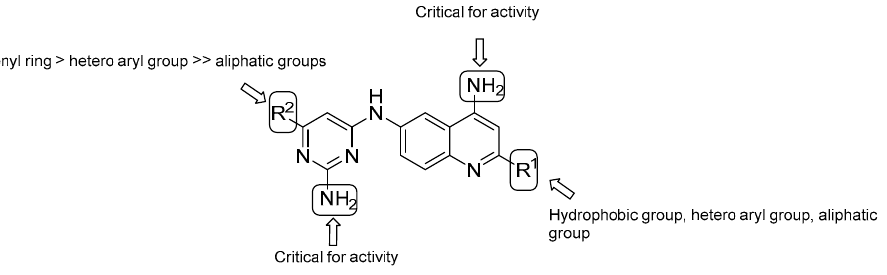
Figure 4. SARs of quinolinyl pyrimidine derivatives.